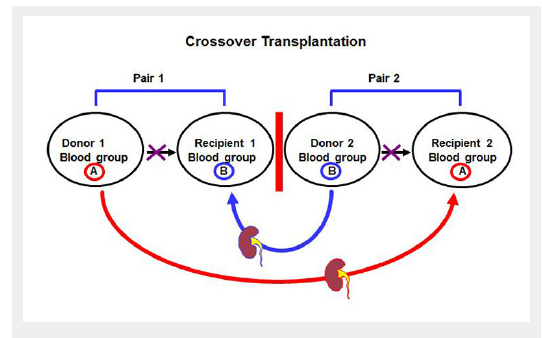
Principle of crossover kidney transplantation between two pairs with incompatible blood